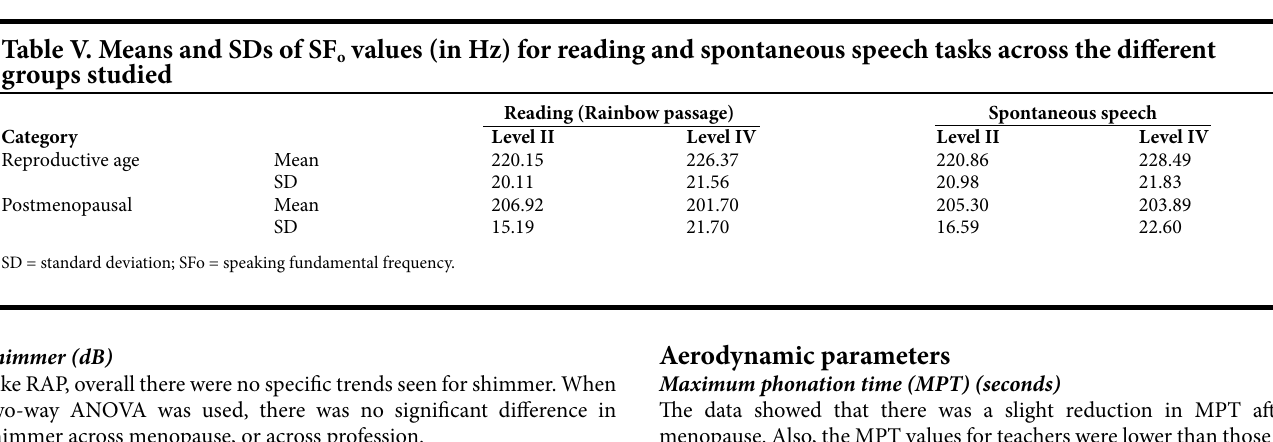
Table V. Means and SDs of SF groups studied